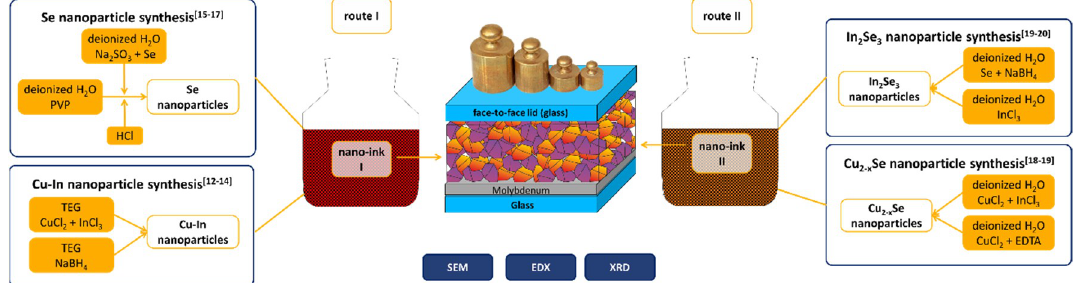
Figure 1. Schematic overview on the experimental processes, showing details of nanoparticle synthesis, nano‐inks for process routes I and II, as well as a schematic of the face‐to‐face process. Route Ia uses only ink I from Cu‐In and Se NP, route Ib uses an additional sputtered Cu‐In seeding layer, route II uses ink II from In 2 Se 3 and Cu 2‐ x Se NP and additional Se NP. SEM, scanning electron microscopy; EDX, energy dispersive X‐ray spectroscopy; XRD, X‐ray diffraction; EDTA, ethylenediaminetetraacetic acid; TEG, tetra ethylene glycol; PVP, polyvinylpyrrolidone.